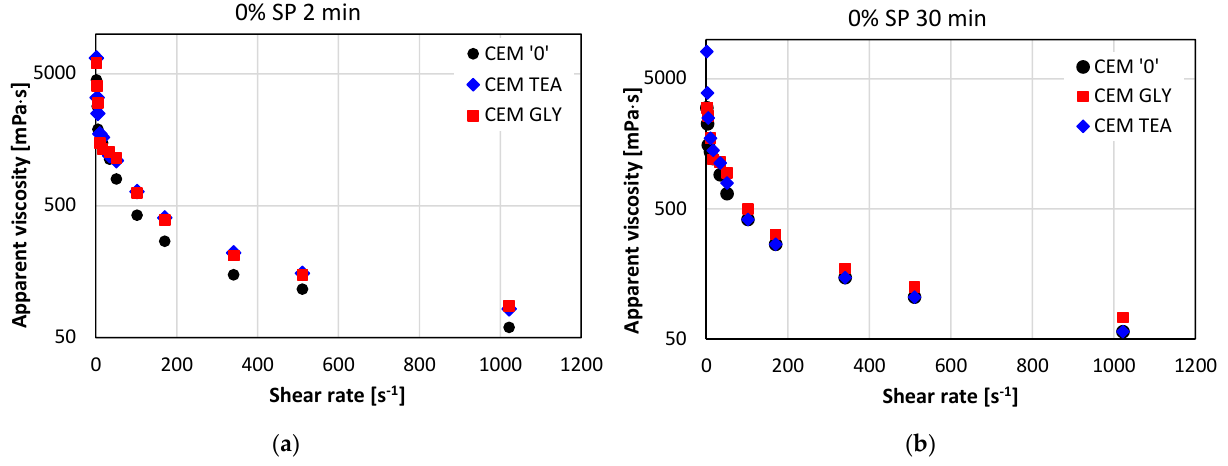
Figure 9. Apparent viscosity of cement pastes without superplasticizer after ( a ) 2 minutes and ( b ) 30 minutes of hydration.